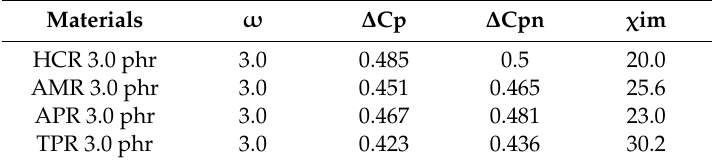
Table 3. Parameter values of rubber composites with varying content fractions of di ff erent